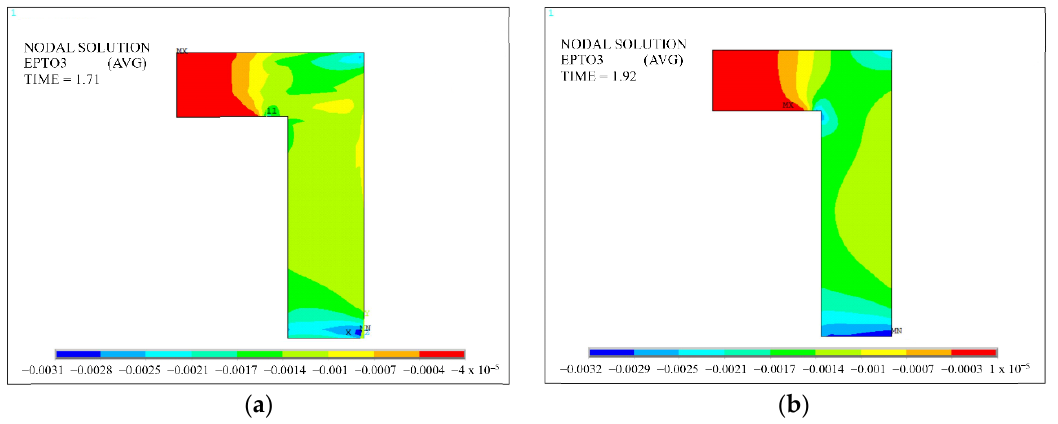
Figure 10. Concrete principal strain distribution: ( a ) CD-45; ( b ) SD-45.